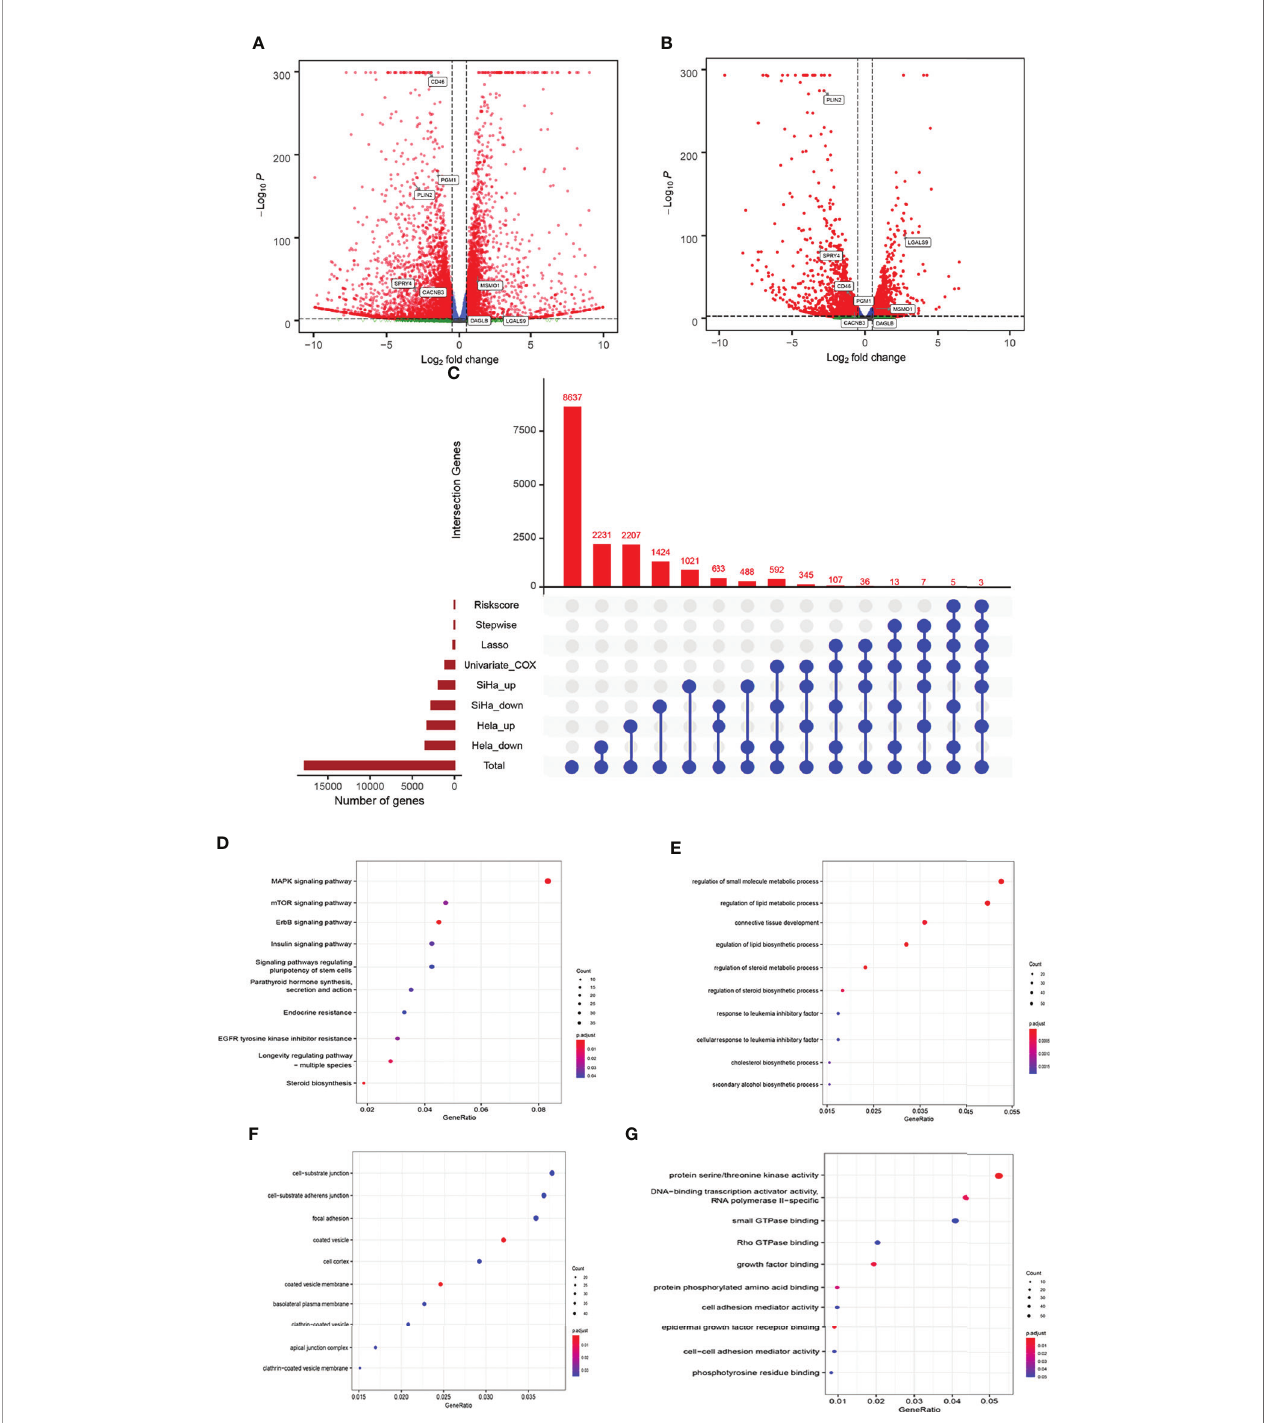
FIGURE 3 | Comparison of gene expression pro fi le which HLA-G induced of cervical cancer. Volcano of signi fi cantly DEGs in SiHa (A) and HeLa (B) , (C) Venn diagram, (D) the bubble plot of KEGG analysis, (E – G) the bubble plot of GO functional enrichment analysis. BP: Biological Precess. CC, Cellular Components. MF, Molecular